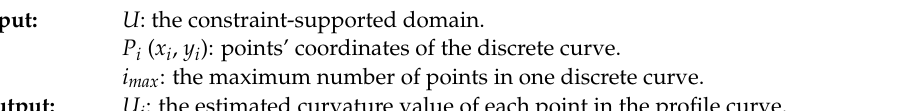
Figure 5. The supported domain of U-chord curvature. Algorithm 1. U-chord curvature method of discrete curve. Algorithm 1. U-chord curvature method of discrete